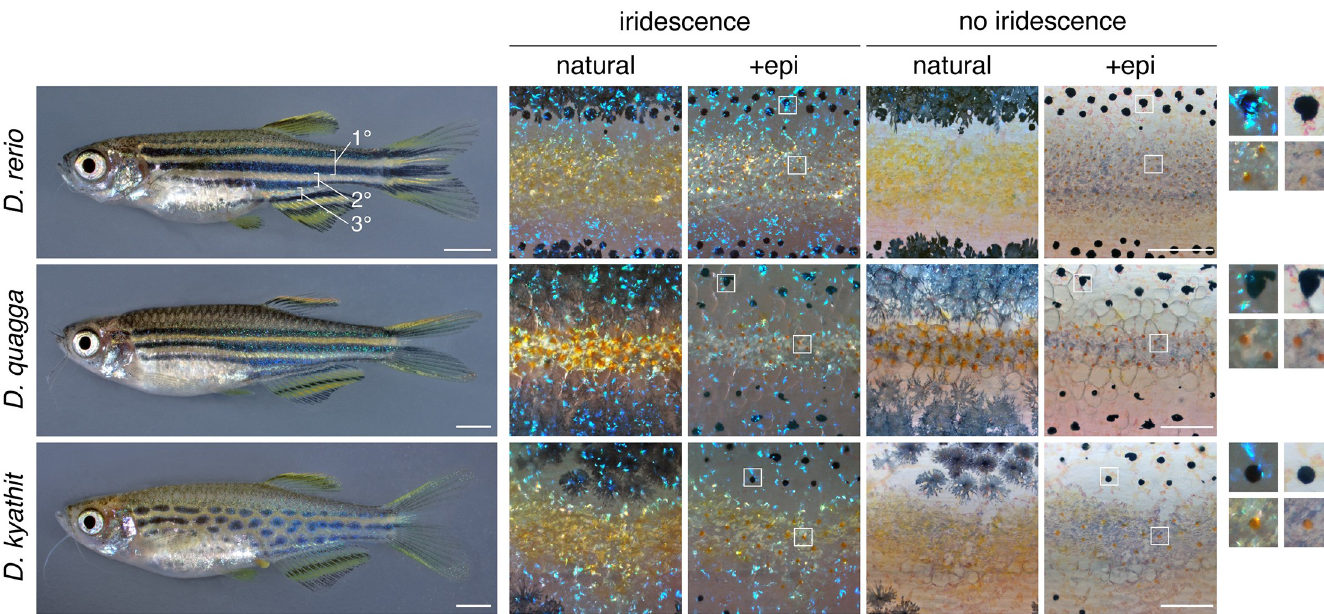
Fig 1. Pigment patterns and cell types. Top , Striped pattern of D . rerio showing primary (1˚) light interstripe with primary dark stripes dorsally and ventrally. Secondary and tertiary interstripes and stripes are indicated only ventrally. Right , Cells that comprise dark and light pattern elements. Lighting has been adjusted to highlight or eliminate the iridescence of iridophores, and pigment cells are shown both in their natural state and after treatment with epinephrine (epi), which contracts pigment granules of melanophores and xanthophores towards cell centers. Insets at far right show higher magnification views of boxed regions. Dark stripes comprise melanophores with black melanin granules as well as more superficial iridophores that have a bluish iridescence owing to precisely oriented stacks of guanine- containing reflecting platelets (upper insets). Interstripes and interspot regions contain densely packed iridophores with a yellowish hue owing to disordered stacks of reflecting platelets, as well as more superficially located xanthophores, marked by lipid droplets containing yellow–orange carotenoids [6,54]. Middle and Bottom , Striped and spotted patterns of D . quagga and D . kyathit . Cell types present in each species were indistinguishable from those of D . rerio . In older D . kyathit and D . quagga , red pigment cells—erythrophores—were present and especially prominent in males, whereas D . quagga developed fissures and other disruptions in their stripes, especially in females (S1 Fig). Neither of these features occurs in D . rerio and we do not consider them further in this study. Scale bars, 2 mm (left) and 200 μ m (right).